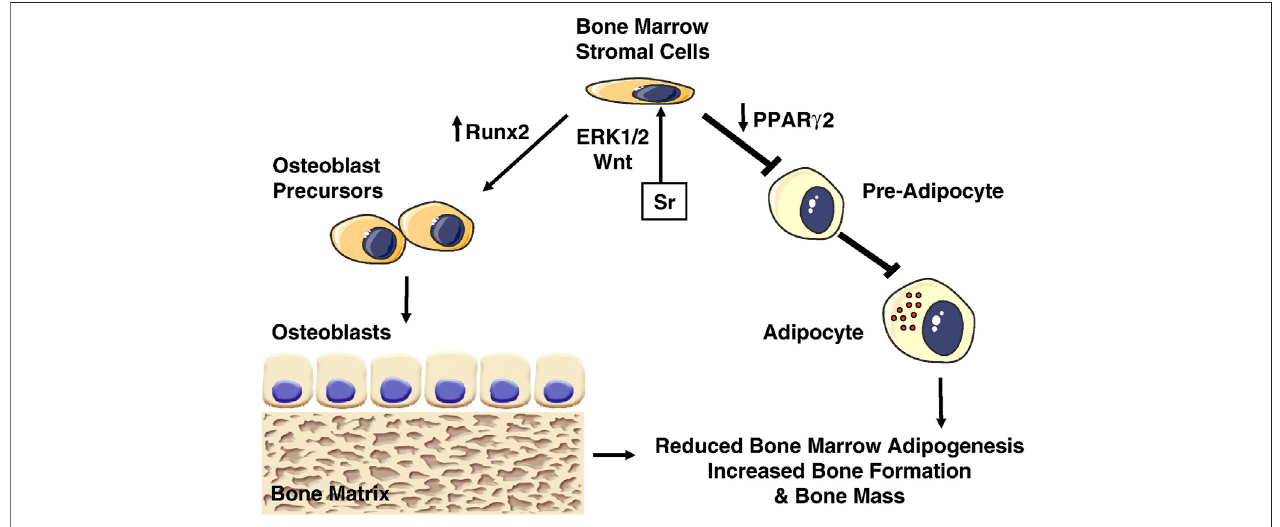
FIGURE 1 | Effects of Strontium (Sr) on bone marrow stromal cells. Sr promotes osteogenesis by activating Wnt and ERK1/2-MAPK signaling pathways, which increase Runx2 and decrease PPAR γ 2 expression, inhibiting adipogenesis and increasing osteoblastogenesis (Saidak and Marie, 2012).